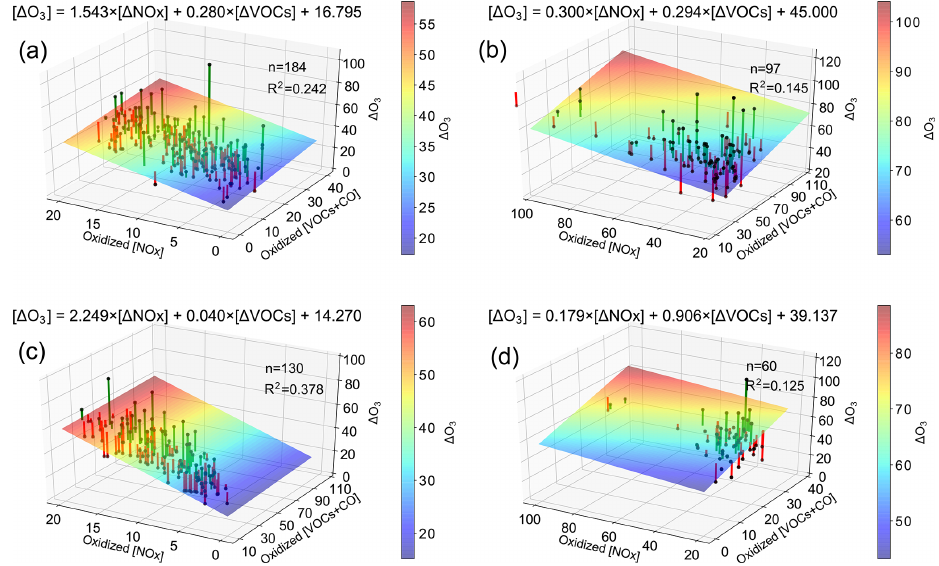
Figure 7. Three-dimensional depiction of ozone formation rate ( (cid:49) O 3 , z axis) plotted as a function of oxidized NO x ( x axis) and oxidized VOC ( y axis). The black dots denote values of (cid:49) O 3 , the colored plane is the best linear fit to the black dots, and the green and red bars denote positive and negative deviations from the plane, respectively. The equation listed represents the surface as a function of oxidized NO x and oxidized VOC. R 2 is the square of correlation coefficient of the linear regression. Four quadrants: (a) low NO x and low VOC (NO x < 20ppb, VOC < 25ppb), (b) high NO x and high VOC (NO x > 20ppb, VOC > 25ppb), (c) low NO x and high VOC (NO x < 20ppb, VOC > 25ppb), (d) high NO x and low VOC (NO x > 20ppb, VOC < 25ppb).